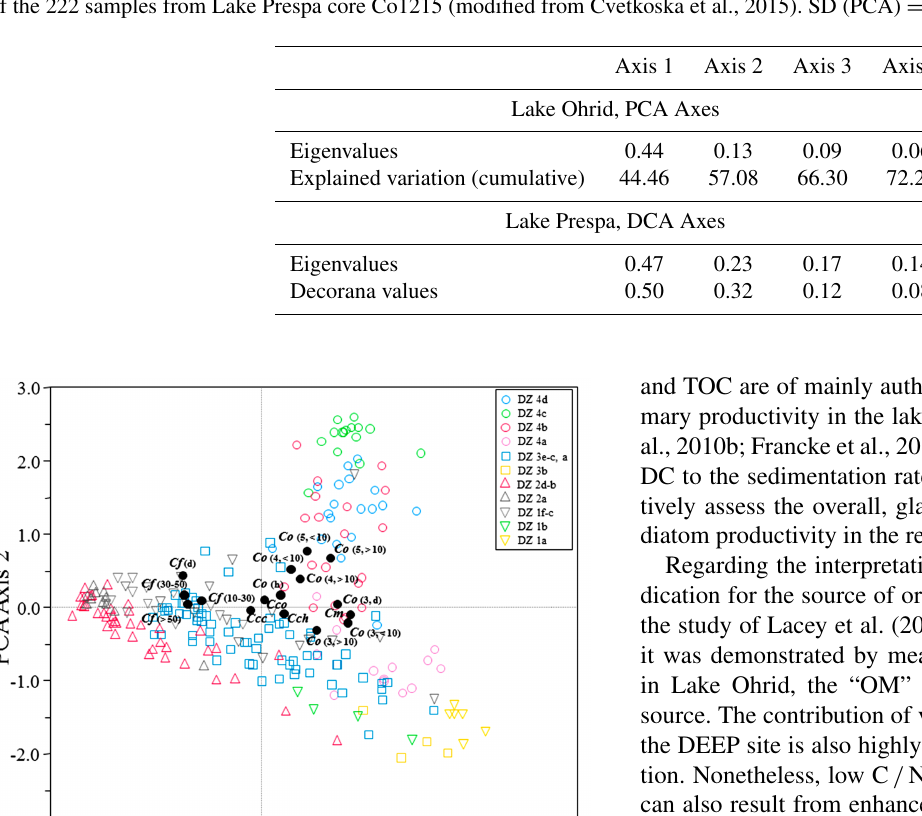
Table 2. Summary results of the unconstrained PCA ordination of 235 diatom samples from Lake Ohrid DEEP core and the DCA ordination of the 222 samples from Lake Prespa core Co1215 (modified from Cvetkoska et al., 2015). SD (PCA) = 2.2, SD (DCA) > 2.5.